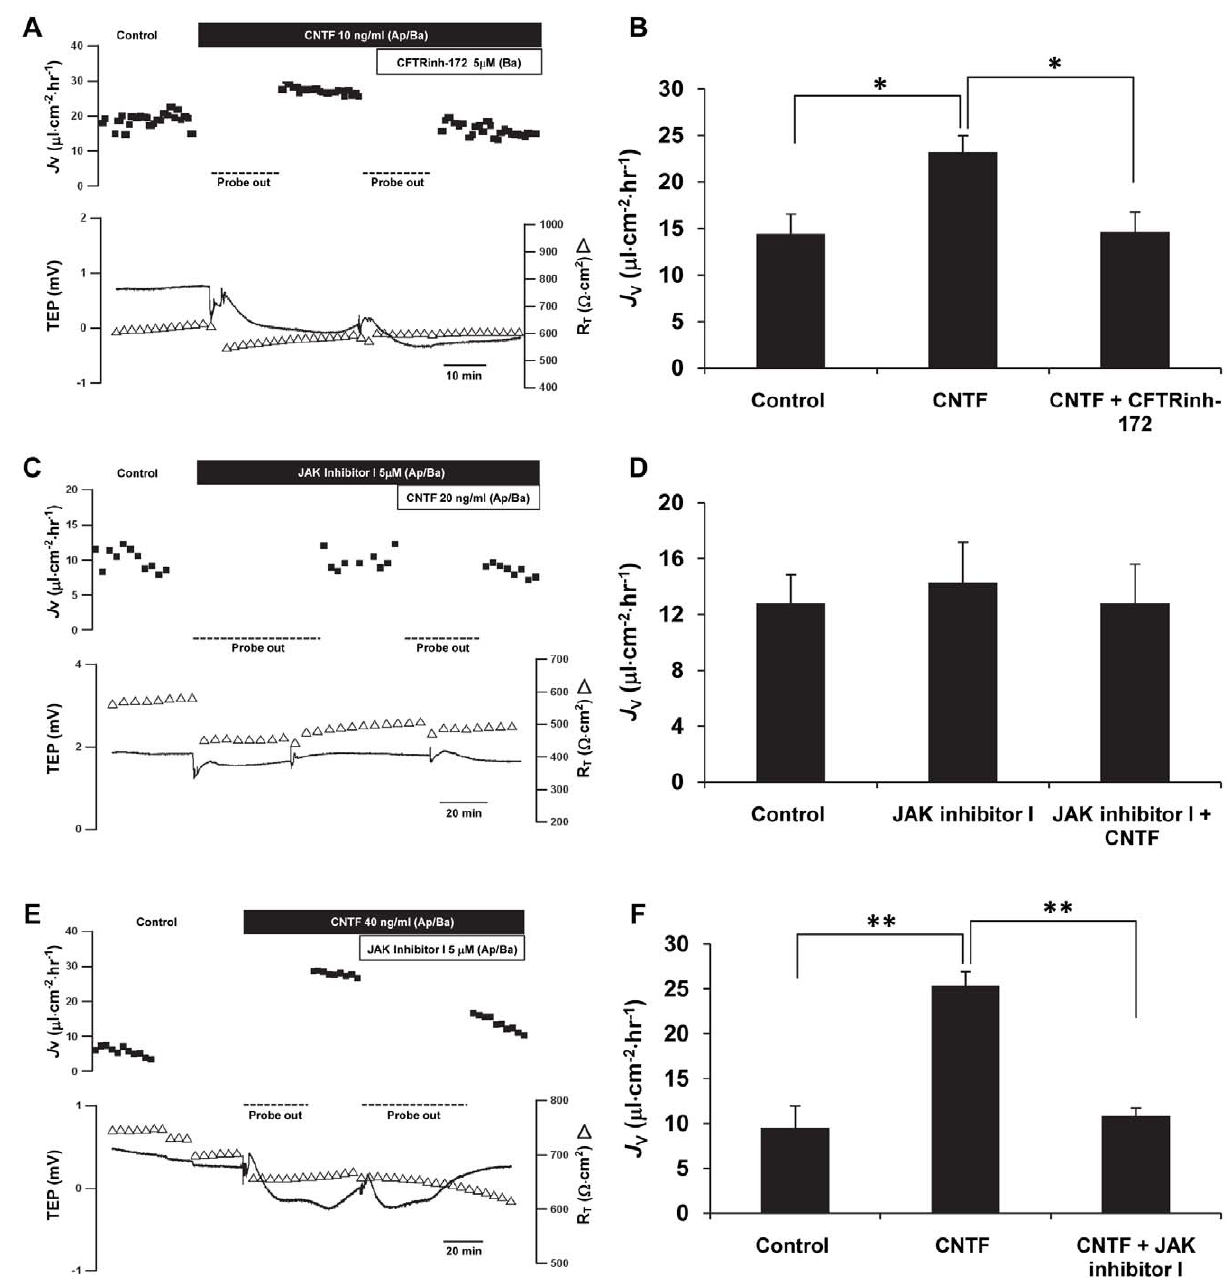
experiments, left- hand panels ( A, C, E ), summary bar graphs are shown on the right-hand side ( B, D, F, respectively) A. Addition of CNTF to the apical and basal bath increased J V across monolayer of hfRPE; subsequent addition of CFTRinh-172 decreased J V back to the baseline levels (n=5). C. Pretreatment with JAK inhibitor I (5 m M) significantly inhibited the effect of CNTF on J V increase (n=3). E. Subsequent addition of JAK inhibitor I decreased